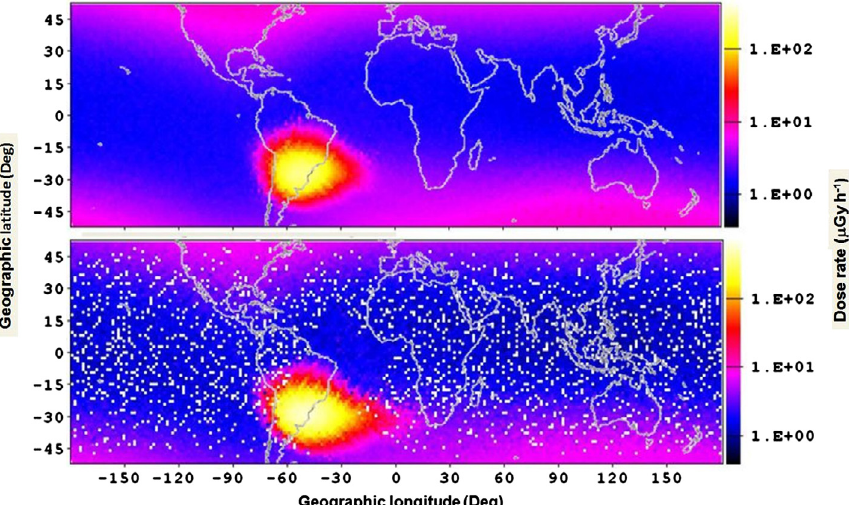
Fig. 4. The geographical distribution of the dose rate recorded by D3 ( l Gy h (cid:2) 1 ). Upper panel – measurements inside the phantom for the time intervals 27 December 2011 to 20 May 2012 and 12 September 2012 to 09 March 2013. Bottom panel – measurements outside the phantom in the period 21 May 2012 to 11 September 2012. On the X -axis is the longitude, on the Y -axis is the latitude, the dose rate intensity is color coded, the small white quadrates indicate the lack of measurements.